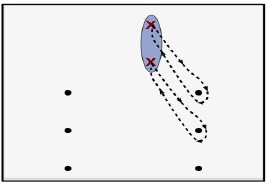
i / 2)) = 0 has a function Q ( u ) evaluated at Figure 1 . A non-local equation f ( Q ( u + i / 2) , Q ( u − two different values of the spectral parameter (red crosses). The distance between the two values is the same as the distance between branch points. It seems then meaningless to attempt defining an analytic continuation of the equation around a branch point as any path (dashed lines) will i / 2) . A possible way to resolve inevitably encircle different such points for Q ( u + i / 2) and Q ( u − the problem is given in section 3.5, figure